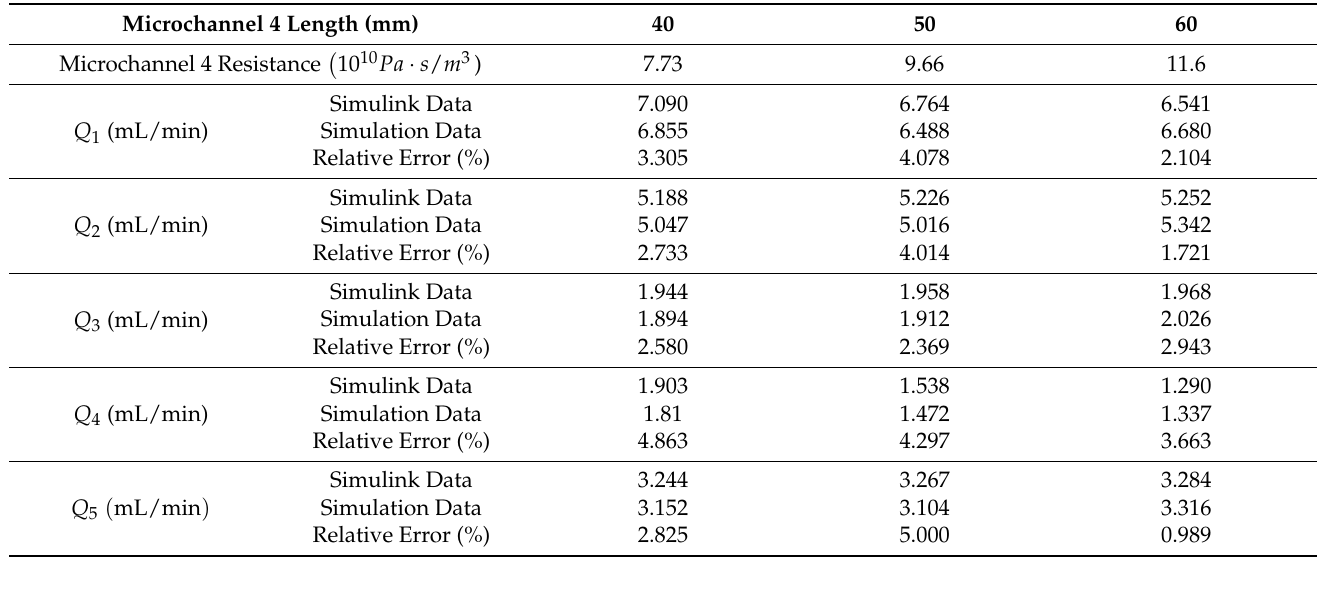
Table 3. Simulation results under different lengths of microchannel 4.